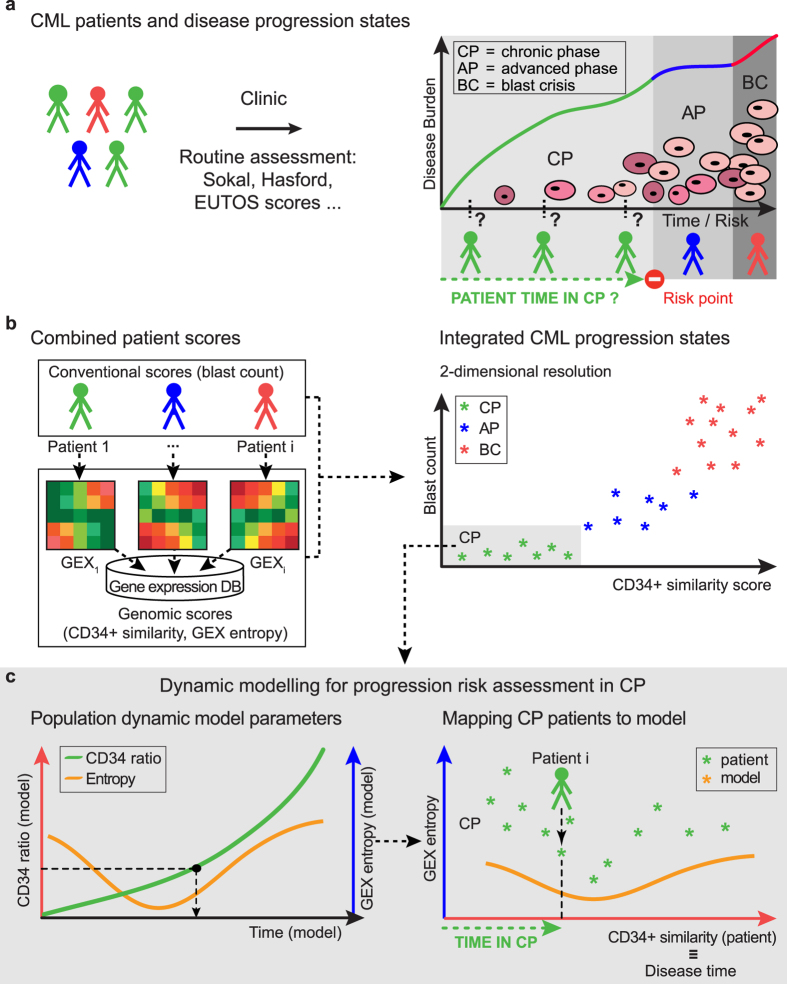
Analysis Workflow.Workflow outlining rationale and analytical pipeline. (a) Established clinical parameters classify CML patients in disease progression states regardless of genomic profile. (b) Combination of conventional scores, e.g. blast count, with patient gene expression (GEX) - derived genomic scores “CD34+ similarity” and “entropy” enables patient characterisation according to complementary scores at increased resolution. CD34+ similarity indicates disease history and progression risk, entropy is a quantitative measure of disorder or lack of GEX co-regulation. (c) Focus on CP patient progression risk assessment according to the CML population dynamic model by Dingli et al.15. The model parameter CD34 ratio reflects cell population dynamics and is correlated with patient CD34+ similarity scores. Non-monotonic evolution of the model parameter entropy serves as alignment marker to map patient gene expression and disease time within CP. CP = chronic phase, AP = advanced phase, BC = blast crisis of CML.